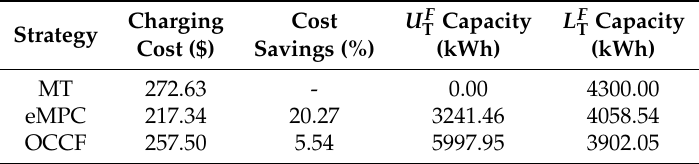
Table 5. Strategies’ overall simulation results, with uncertainty in the arrival time and initial SoC (three chargers, 11 EV requests).